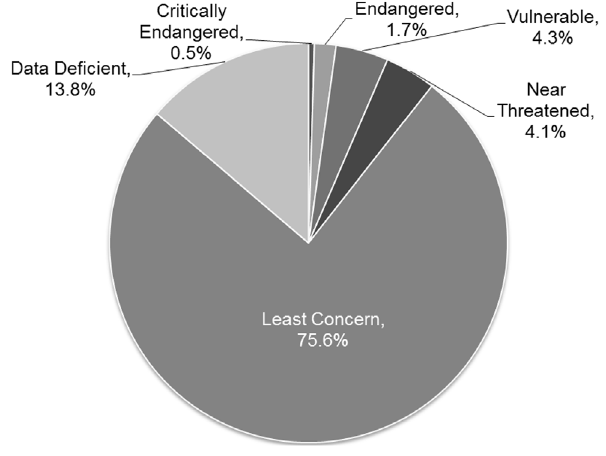
Figure 3. Global extinction risk to Conus . The percentage contribution for each assessed category to the global diversity of 632 spp of Conus . These are represented by 3 Critically Endangered species; 11 Endangered; 27 Vulnerable; 26 Near Threatened; 87 Data Deficient, and 478 of Least Concern.